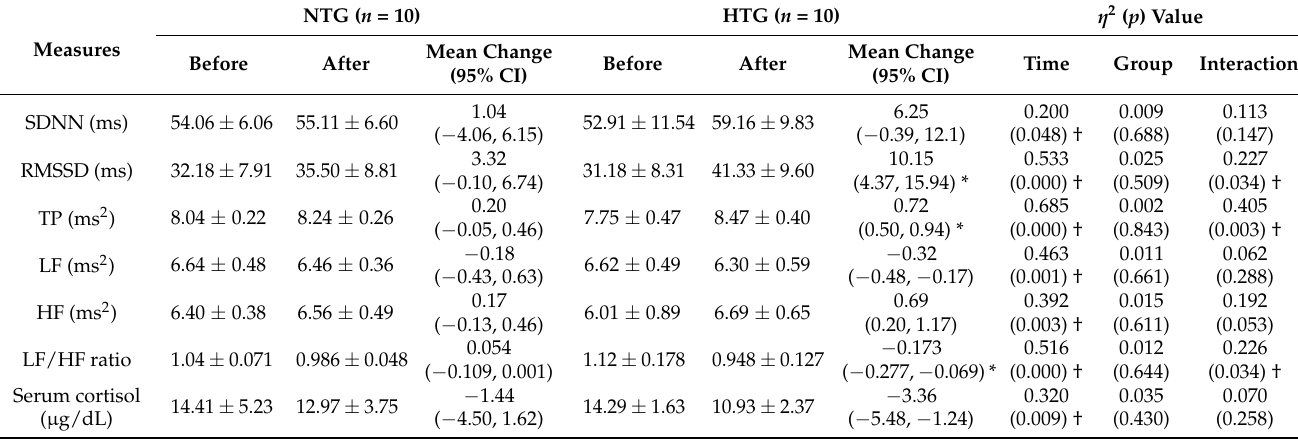
Table 5. Changes in autonomic nervous system function before versus after training by